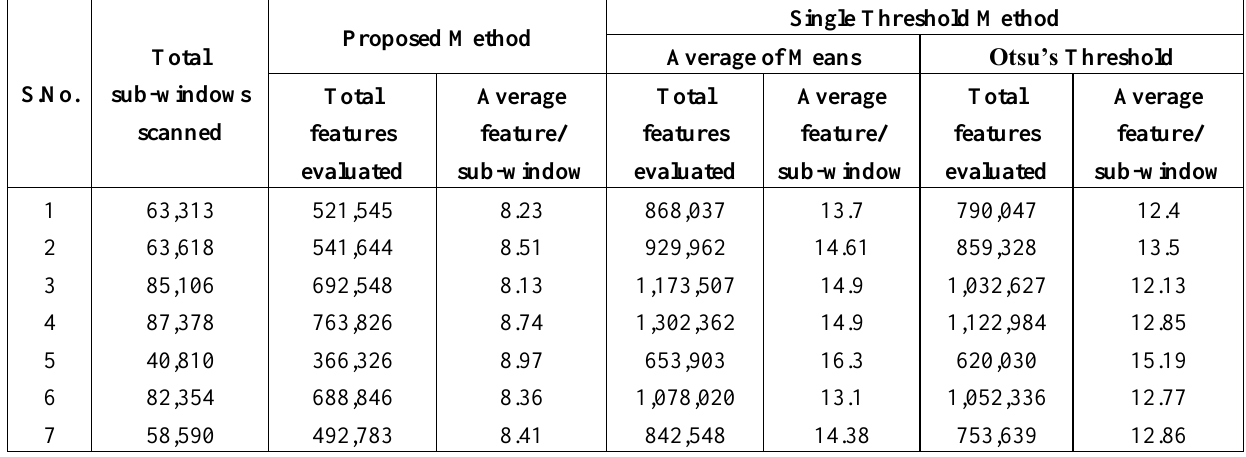
Table 1. Comparison of the speed of the detectors in terms of the average number of features evaluated per scanned window in the test images